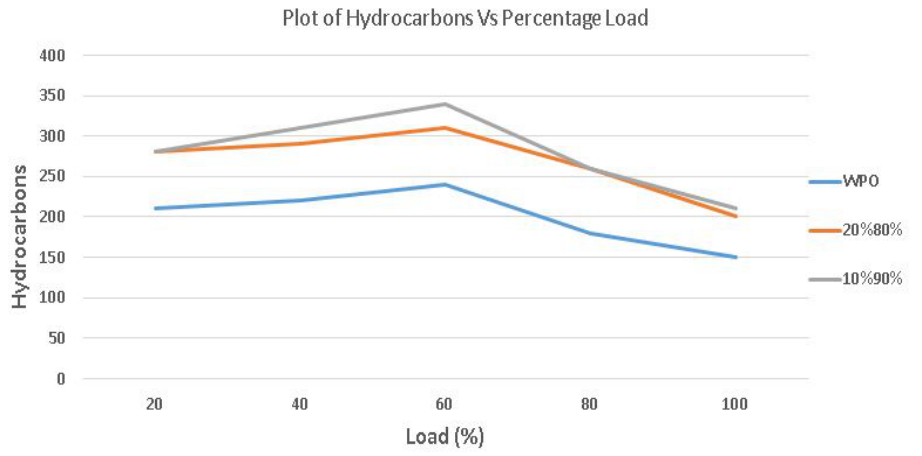
Figure 6. Plot of hydrocarbons vs. percentage